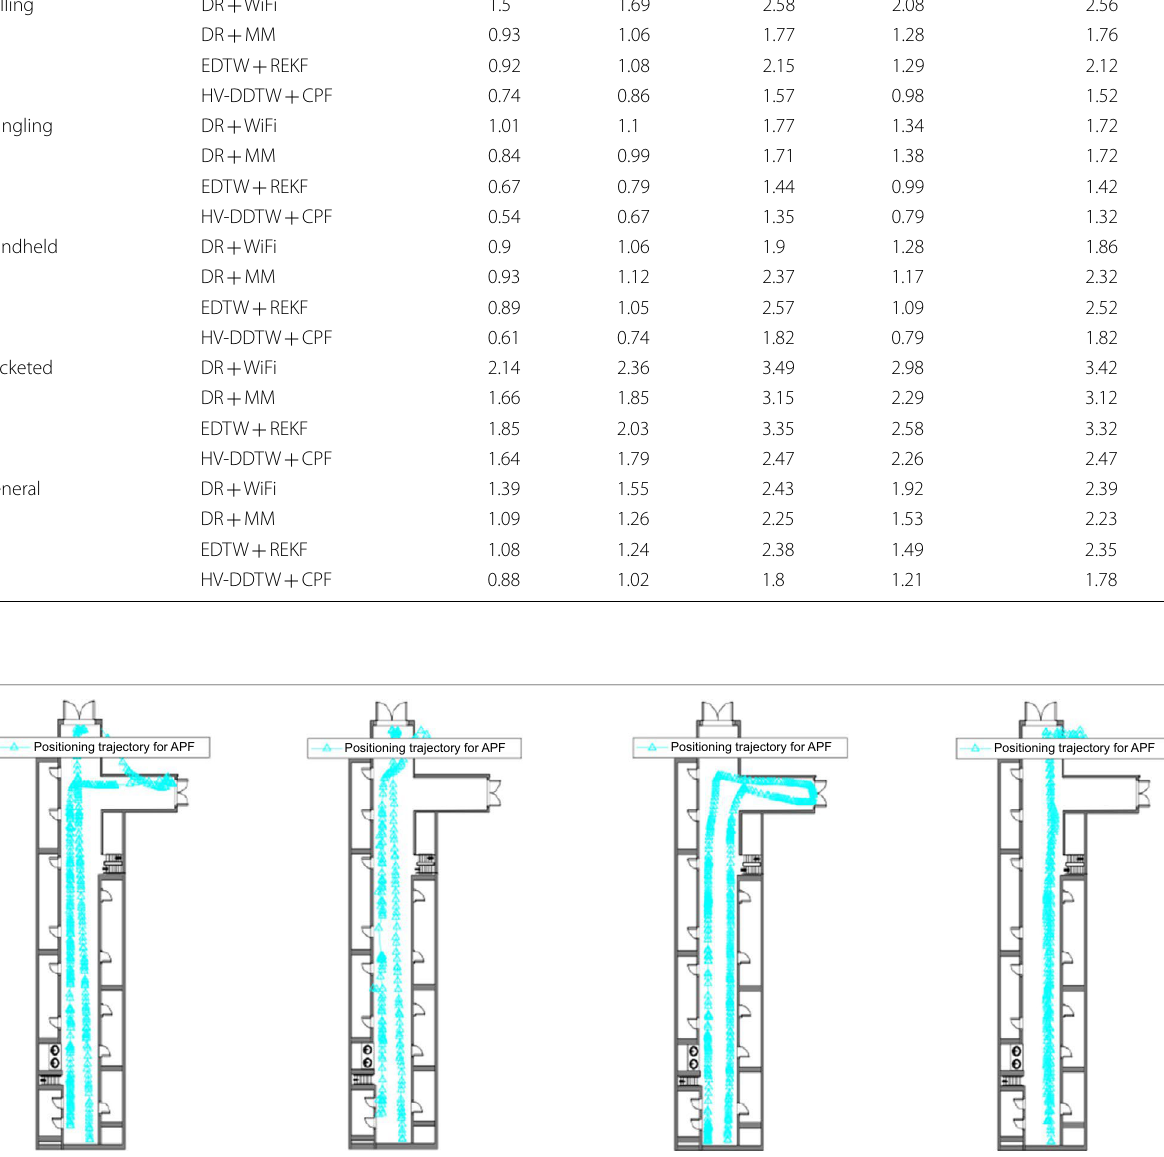
REKF, and HV-DDTW +